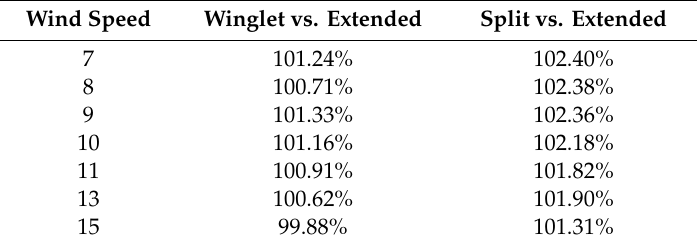
Table 2. Relative thrust of the simulated wind